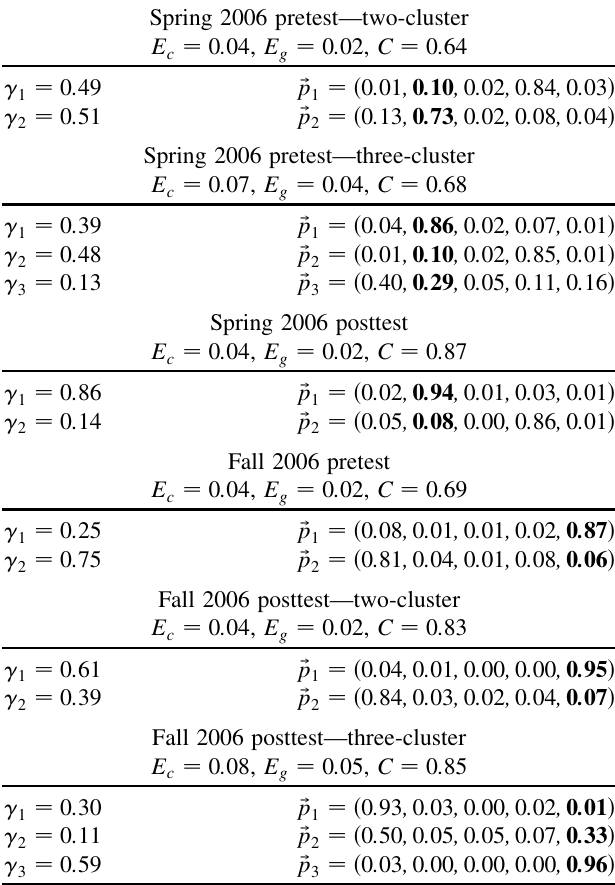
TABLE III. Group population fractions and vectors. Correct Using the results of the previous section, the subgroup answer shown in bold face. Note that some vectors do not add to models extracted by k -means have predicted misassign- 1 because of accumulated rounding error. C is the course con- is the centroid error, and E the sistency as defined in Eq. (6), E c g group error. Spring 2006